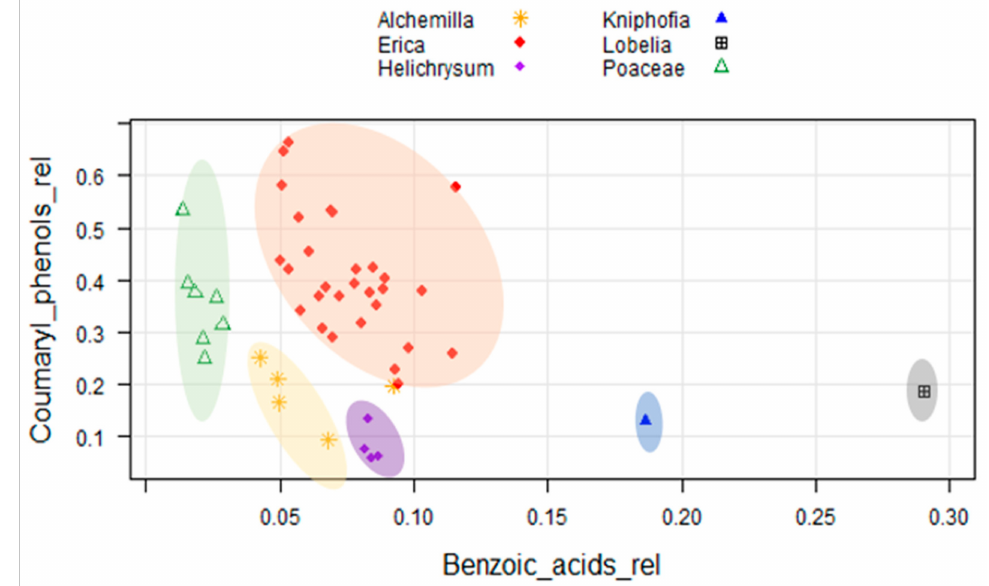
Figure 6. Two-dimensional plot of the relative contribution of the sum of coumaryl phenols ( p– coumaric acid + ferulic acid) and benzoic acids (benzoic acid + salicylic acid + phthalic acid) in the dominant plant species under study.